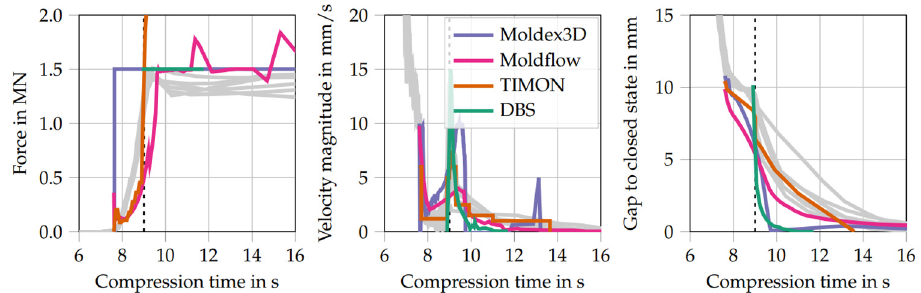
Figure 12. Press data from several parts molded with Configuration A (gray) compared with the numerical compression profiles predicted by M OLDEX 3D (purple) and M OLDFLOW (pink), 3D TIMON (orange), and Direct Bundle Simulation (green). The dashed lines indicate the switch from displacement control to force